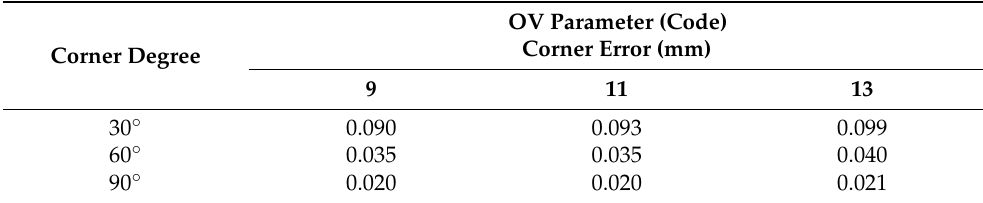
Table 8. Open circuit voltage (OV) vs. corner